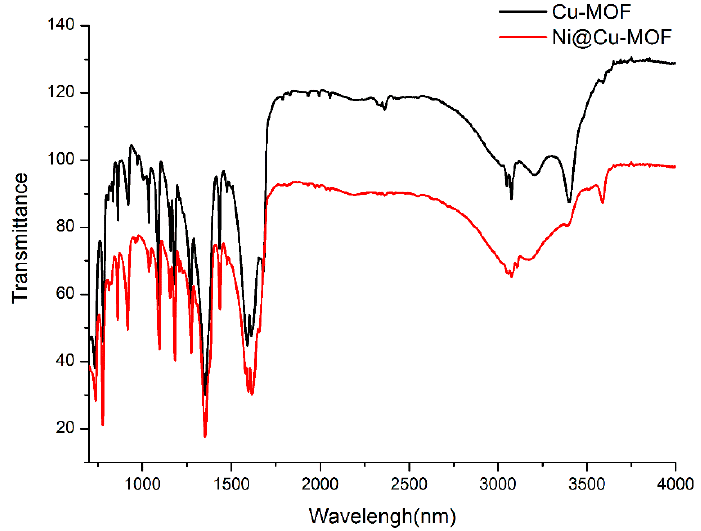
Figure 2. IR spectra of the Cu-MOF and the Ni@Cu-MOF.